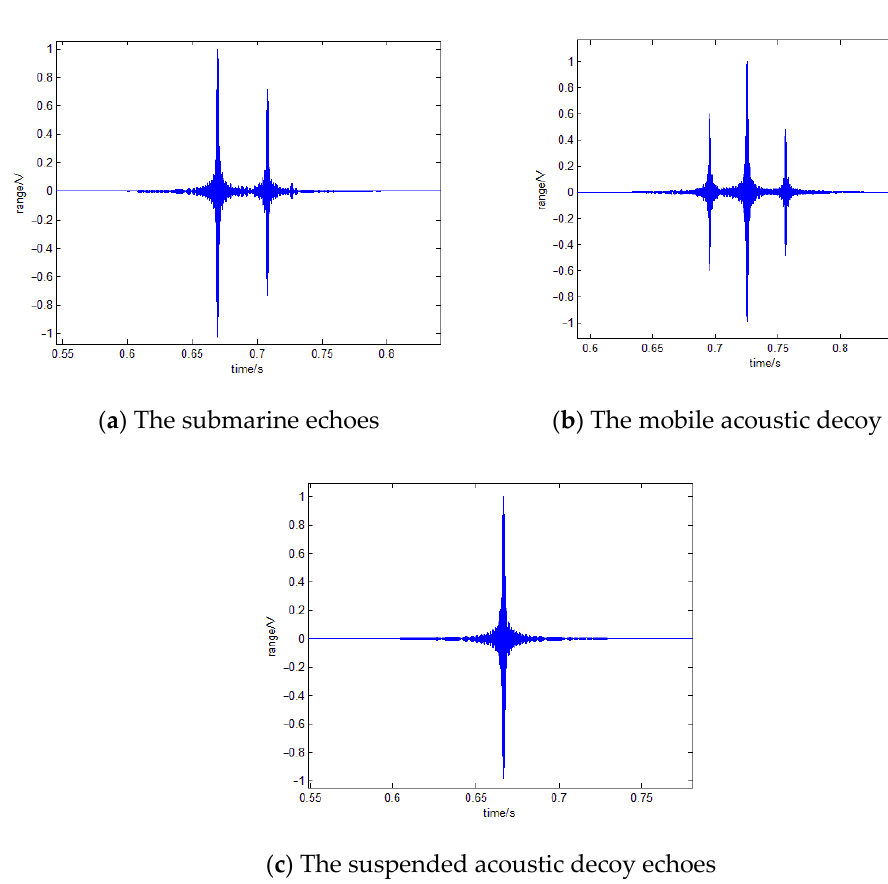
Figure 11. The echoes of each target at 500 m.